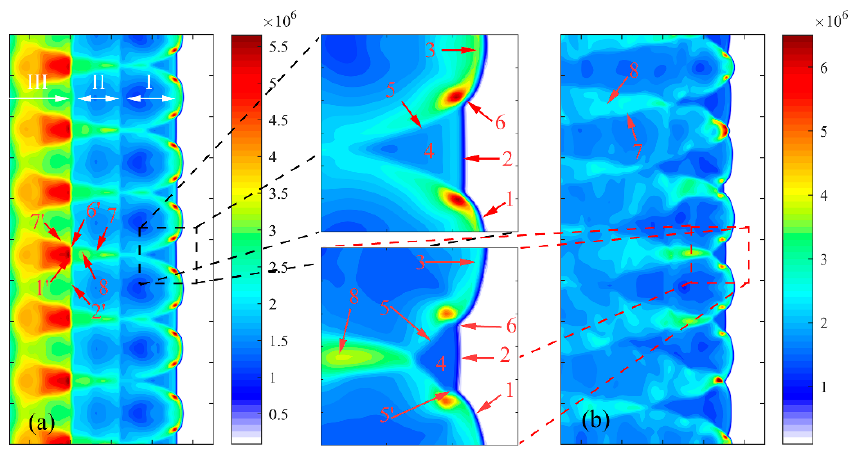
Figure 8. The instantaneous pressure distribution of the detonation wave at ER is 3.0 ( a ); ER is 6.0 ( b ). The propagation direction is from left to right: 1, 1 ′ , shock front (Mach stem); 2, 2 ′ , shock front (incident shock); 3, flame front; 4, induction zone; 5, transverse wave; 5 ′ , weak transverse wave; 6, 6 ′ , triple point; 7, extend of transverse wave; 7 ′ , tail of transverse wave; 8, second induction zone; I, II, III, different reaction zone.